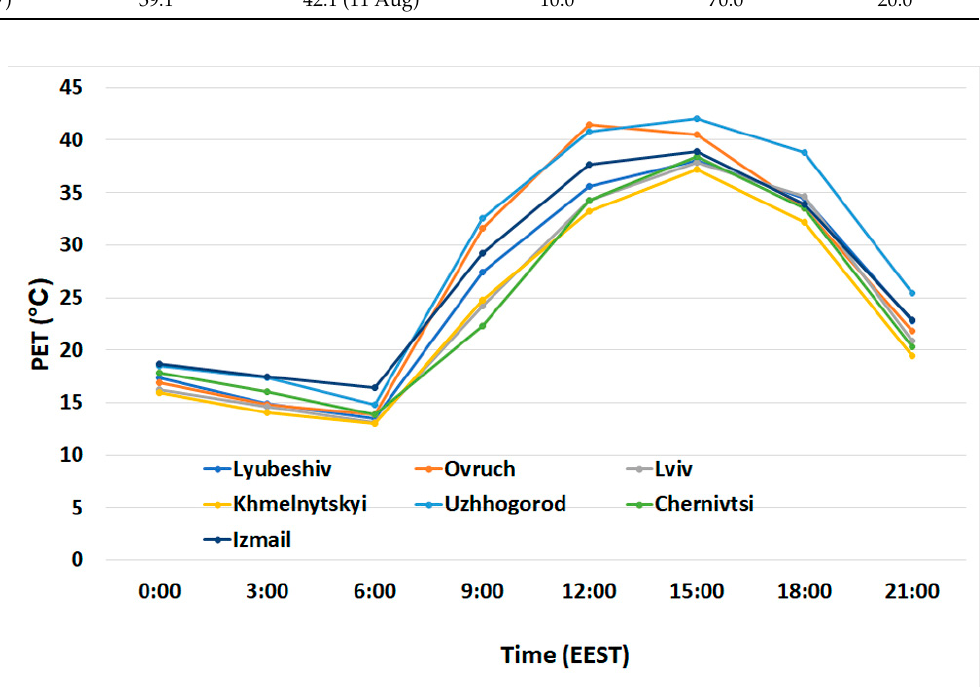
Figure 8. Daily course of mean PET values for the period from 5 to 14 August 2015 for selected stations.